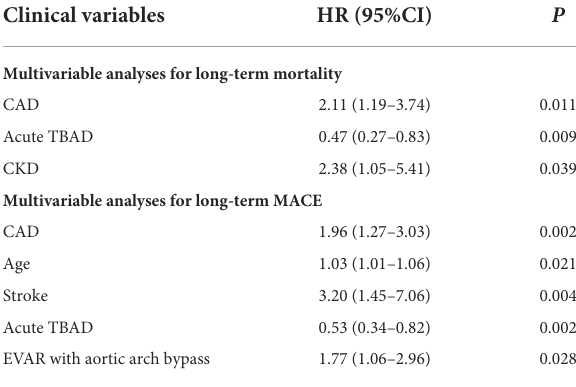
TABLE 4 Multivariable cox regression analyses for long-term mortality and MACE. Clinical